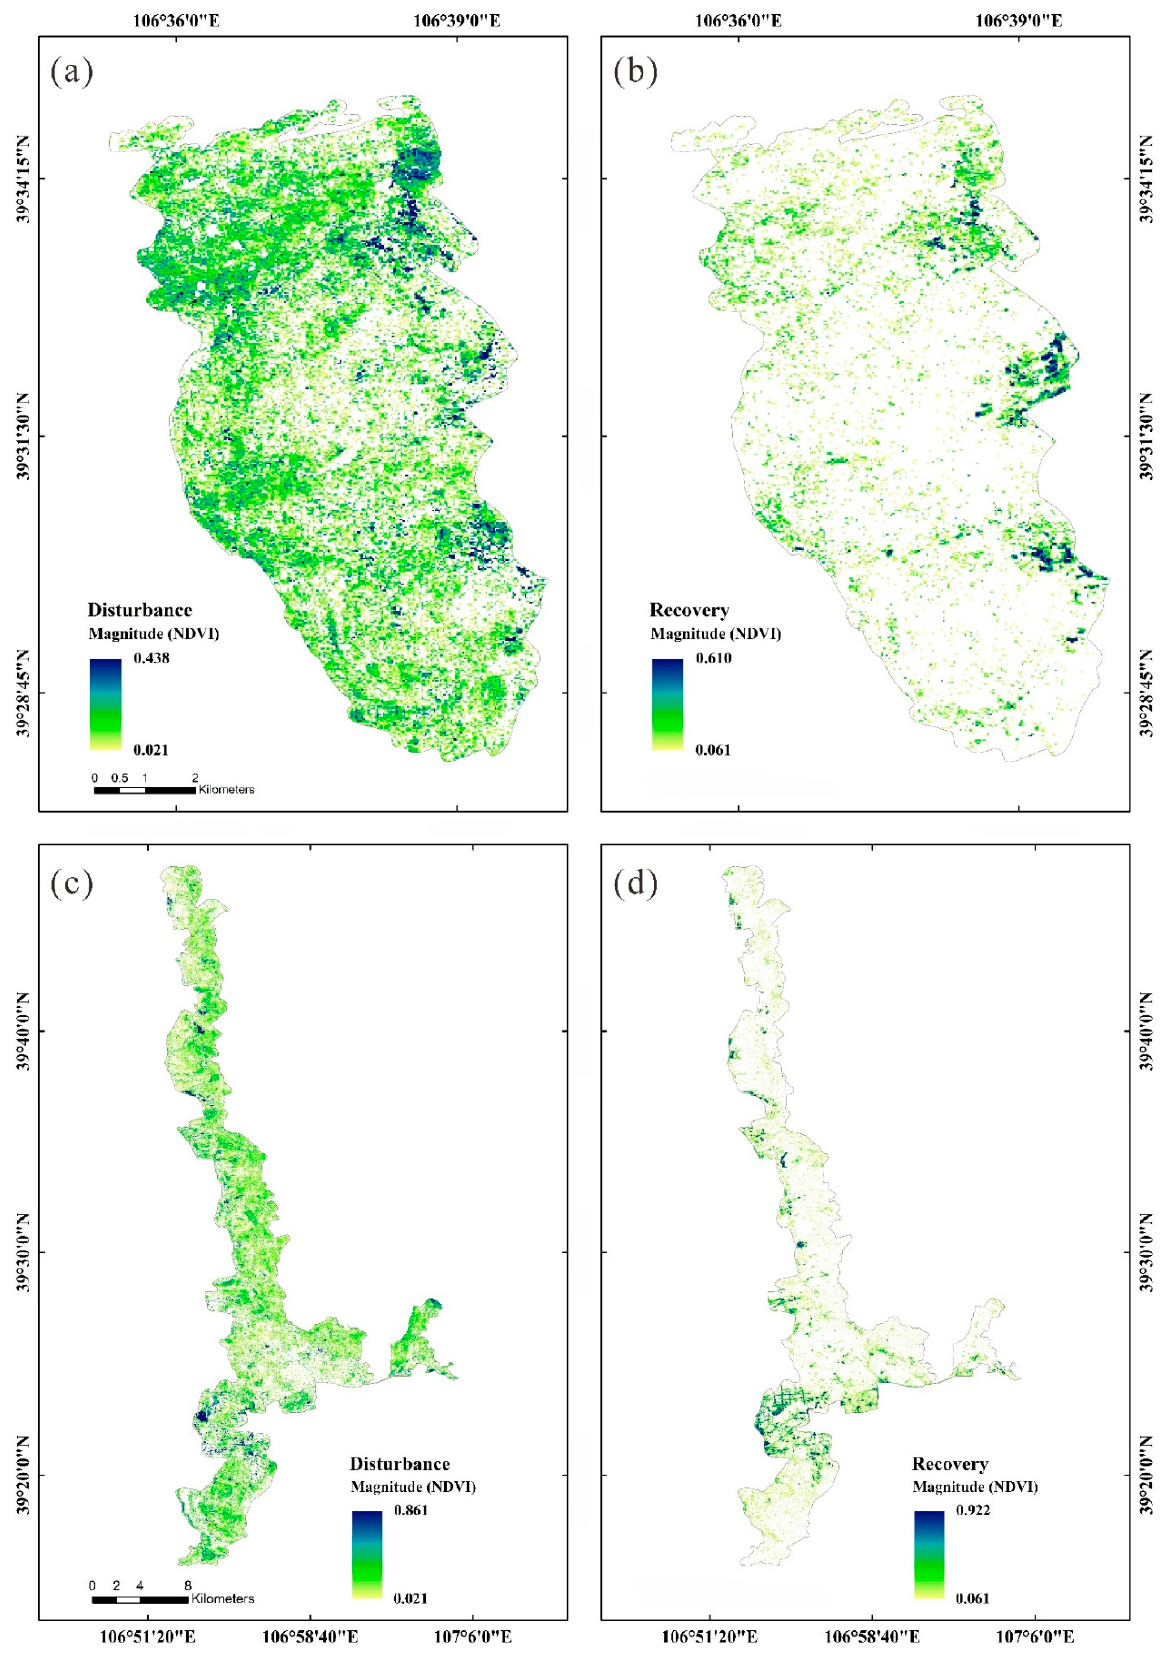
Figure 8. The magnitude of disturbance and recovery. ( a ) disturbance in the western mine; ( b ) recovery in the western mine; ( c ) disturbance in the eastern mine; ( d ) recovery in the eastern mine.